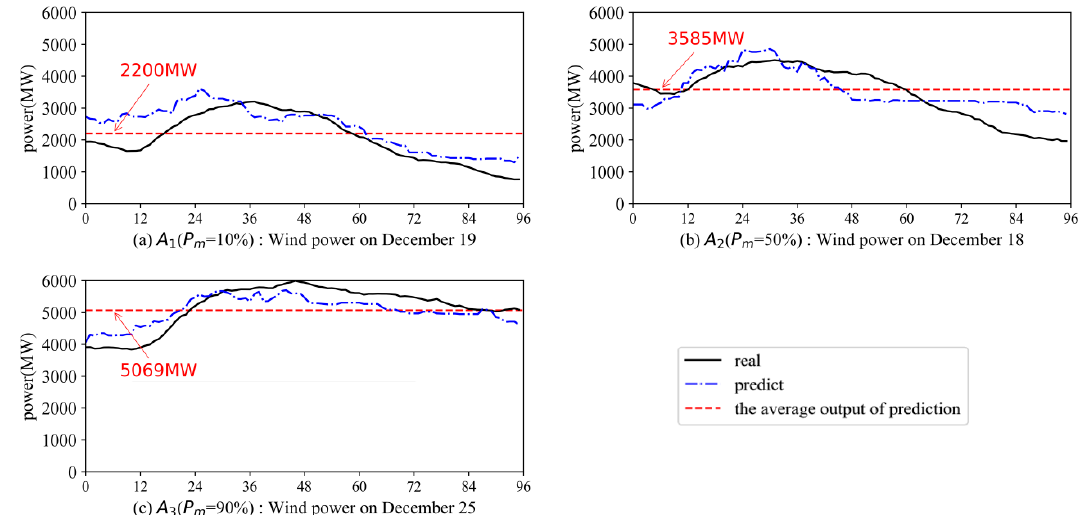
Figure 9. Predicted wind power process of three typical days.